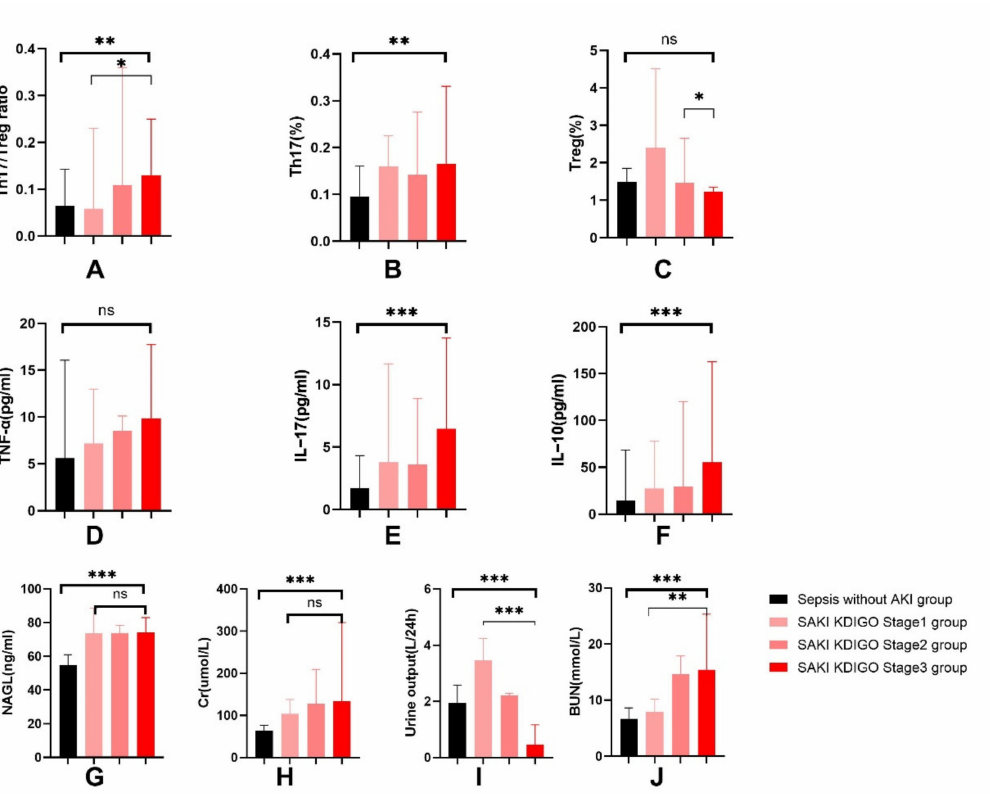
Figure 7. Changes in immune and renal function indicators in sepsis-without-AKI group and different severity of SAKI groups, including Th17/Treg ratio ( A ), Th17 cell ratio ( B ), Treg cell ratio ( C ), TNF- α ( D ), IL-17 ( E ), IL-10 ( F ), NAGL ( G ), Cr ( H ), urine output ( I ) and BUN ( J ). SAKI, sepsis-induced acute kidney injury; NAGL, neutrophil gelatinase-associated lipocalin; Cr, serum creatinine; BUN, blood urea nitrogen; Th17, helper T cell 17; Treg, regulatory T cell; IL-10, Interleukin-10; IL-17, Interleukin-17; TNF- α , Tumor necrosis factor alpha. p value: ns > 0.05, * 0.05–0.01; ** 0.01–0.001; *** <